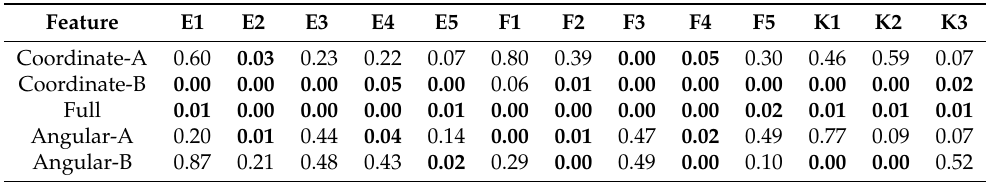
Table 15. p -value of one sided paired t -test of average AUROC of TCN and RNN models. Text in bold denotes p -value less than or equal to 0.05. E, F, and K denote English, freestyle, and Korean patterns, respectively.